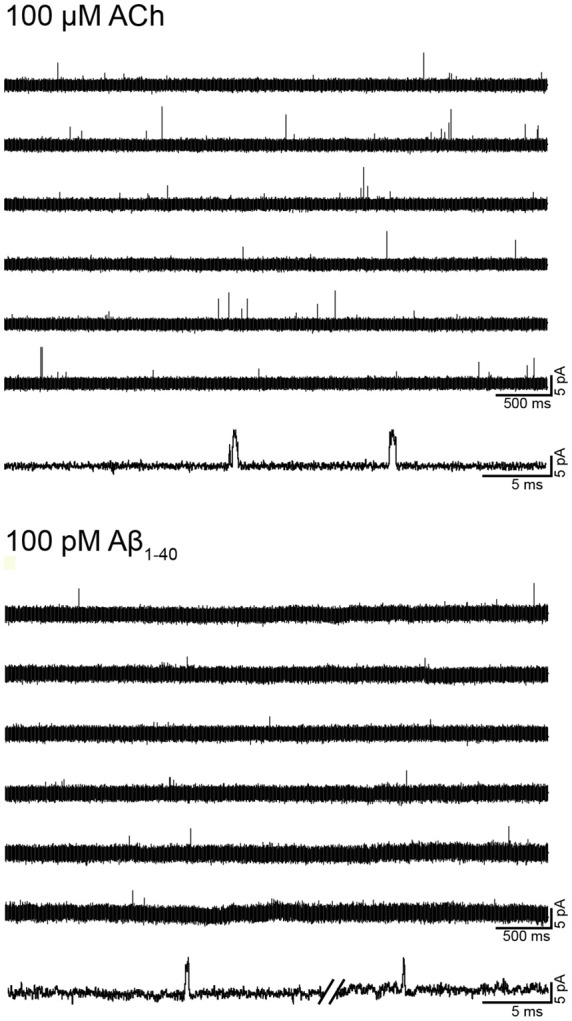
Single-channel activity elicited by Aβ. Single-channel recordings were performed in the cell-attached patch configuration at −70 mV membrane potential. Representative α7 single-channel traces from a continuous recording in the presence of 100 μM acetylcholine (ACh) or 100 pM Aβ1–40. For each condition, a trace at higher temporal resolution is shown (bottom traces). Channel openings are shown as upward deflections. Filter: 9 kHz.